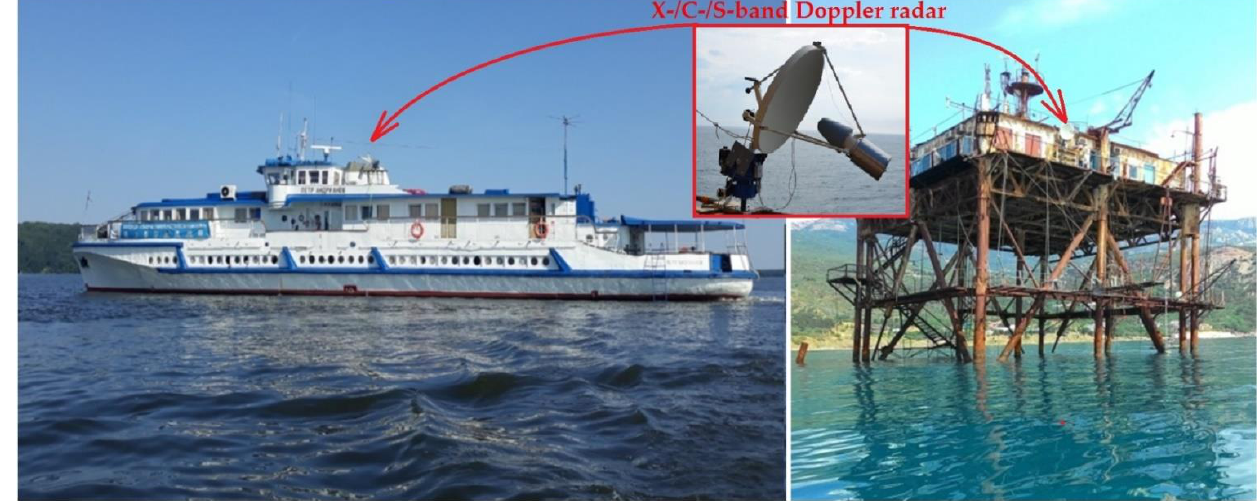
Figure 1. X-/C-/S-band radar mounted onboard the research vessel and the